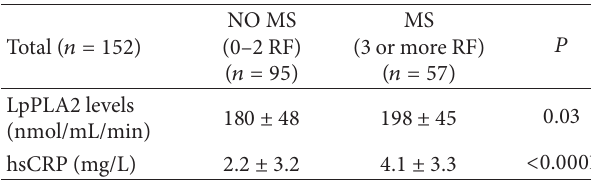
Table 4: Mean levels of hsCRP and Lp-PLA2 by number of metabolic syndrome components according to harmonized criteria 1 in the total sample.